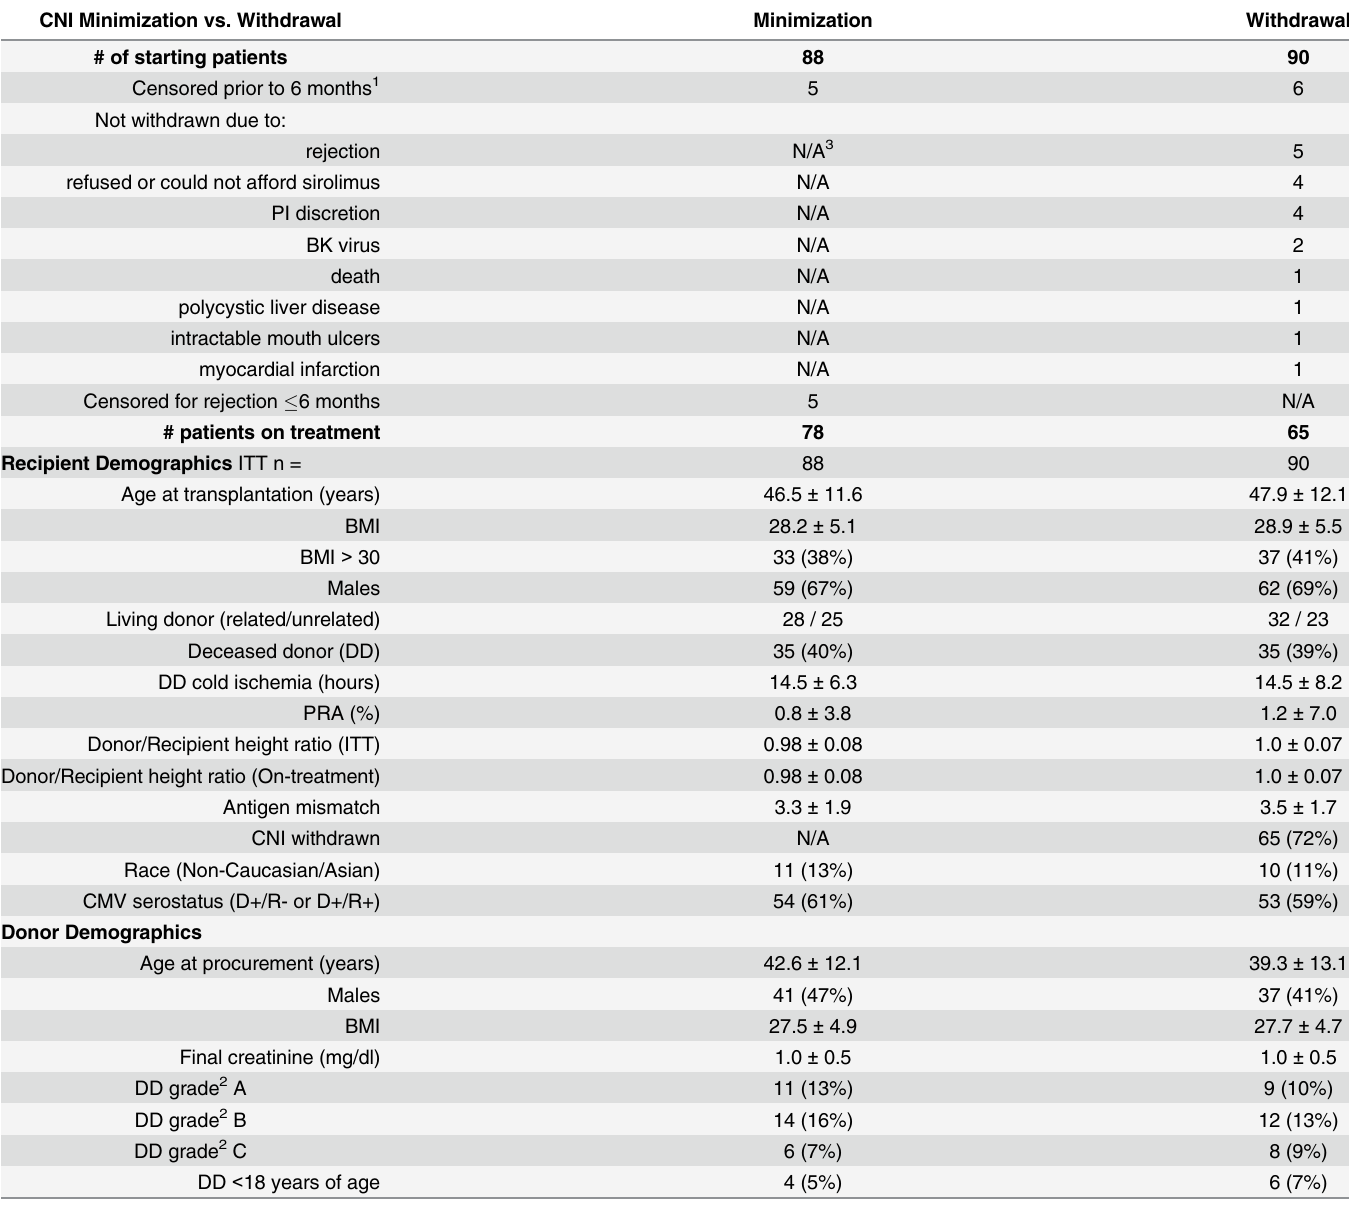
Table 2. Recipient and Donor